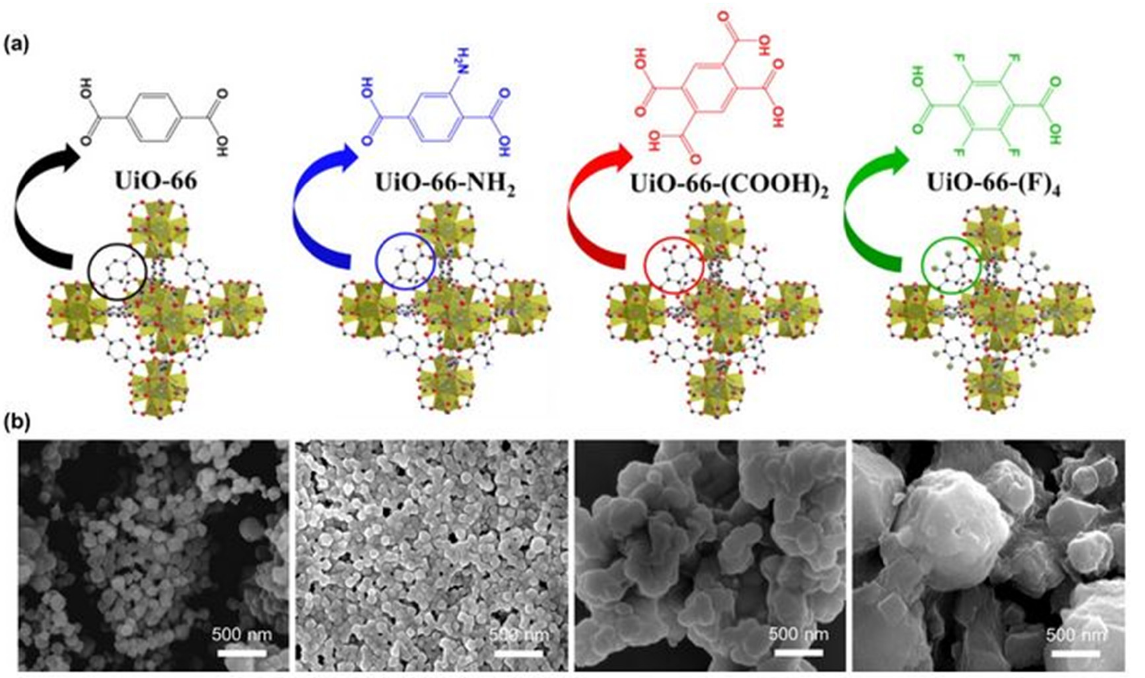
Figure 1. ( a ) The structures of the UiO-66-based MOFs with different functional groups, including UiO-66, UiO-66-NH 2 , UiO-66-(COOH) 2 , and UiO-66-(F) 4 and ( b ) the corresponding SEM images of these synthesized